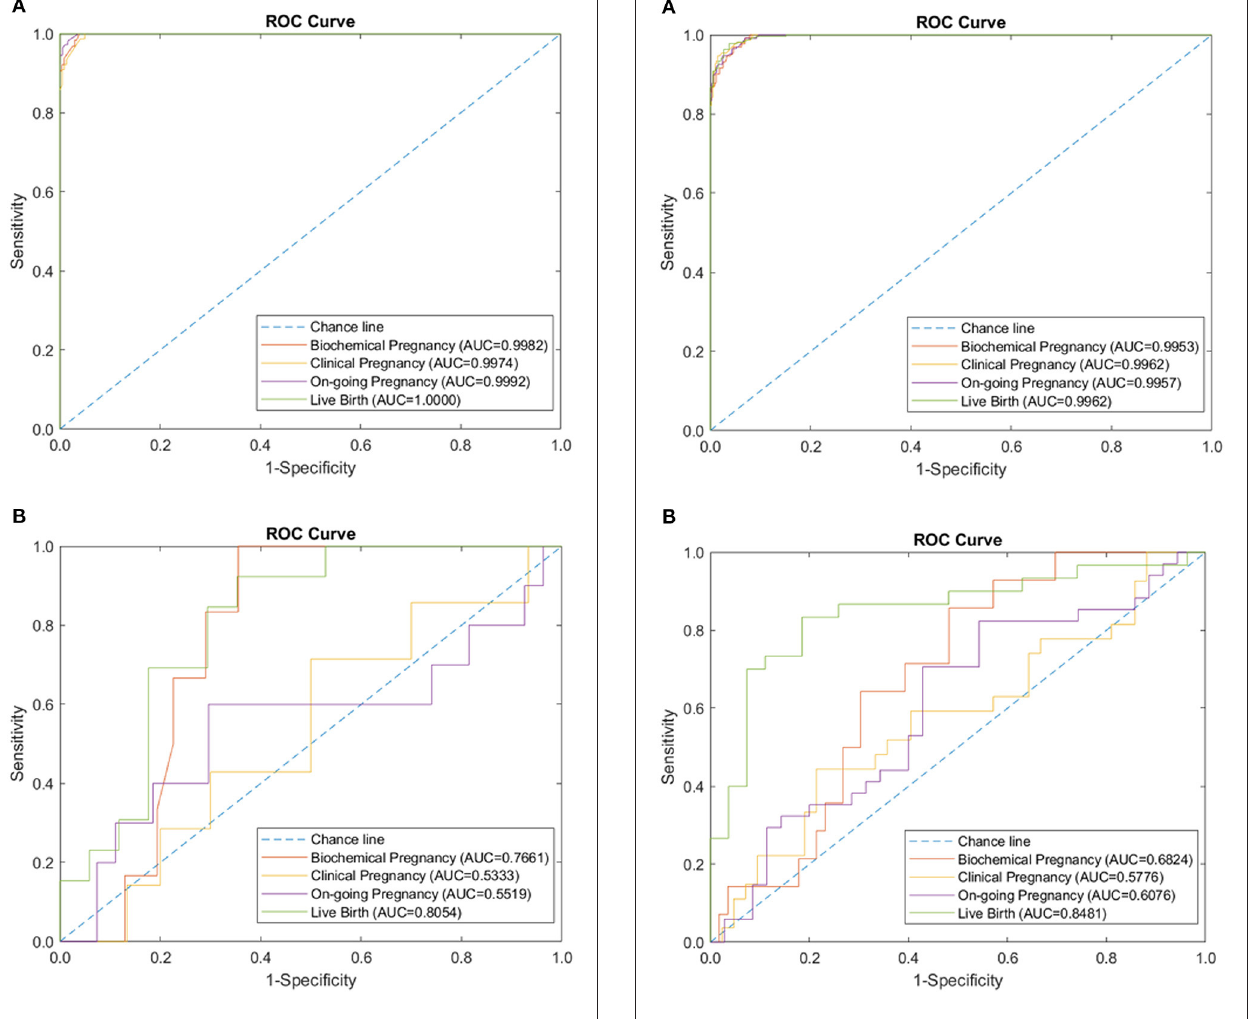
FIGURE 3 | Endometrial immunology panel performance of sparse coding in predicting pregnancy outcomes at different pregnancy periods. (A) ROC plot of the training data set. (B) ROC plot of the testing data set.